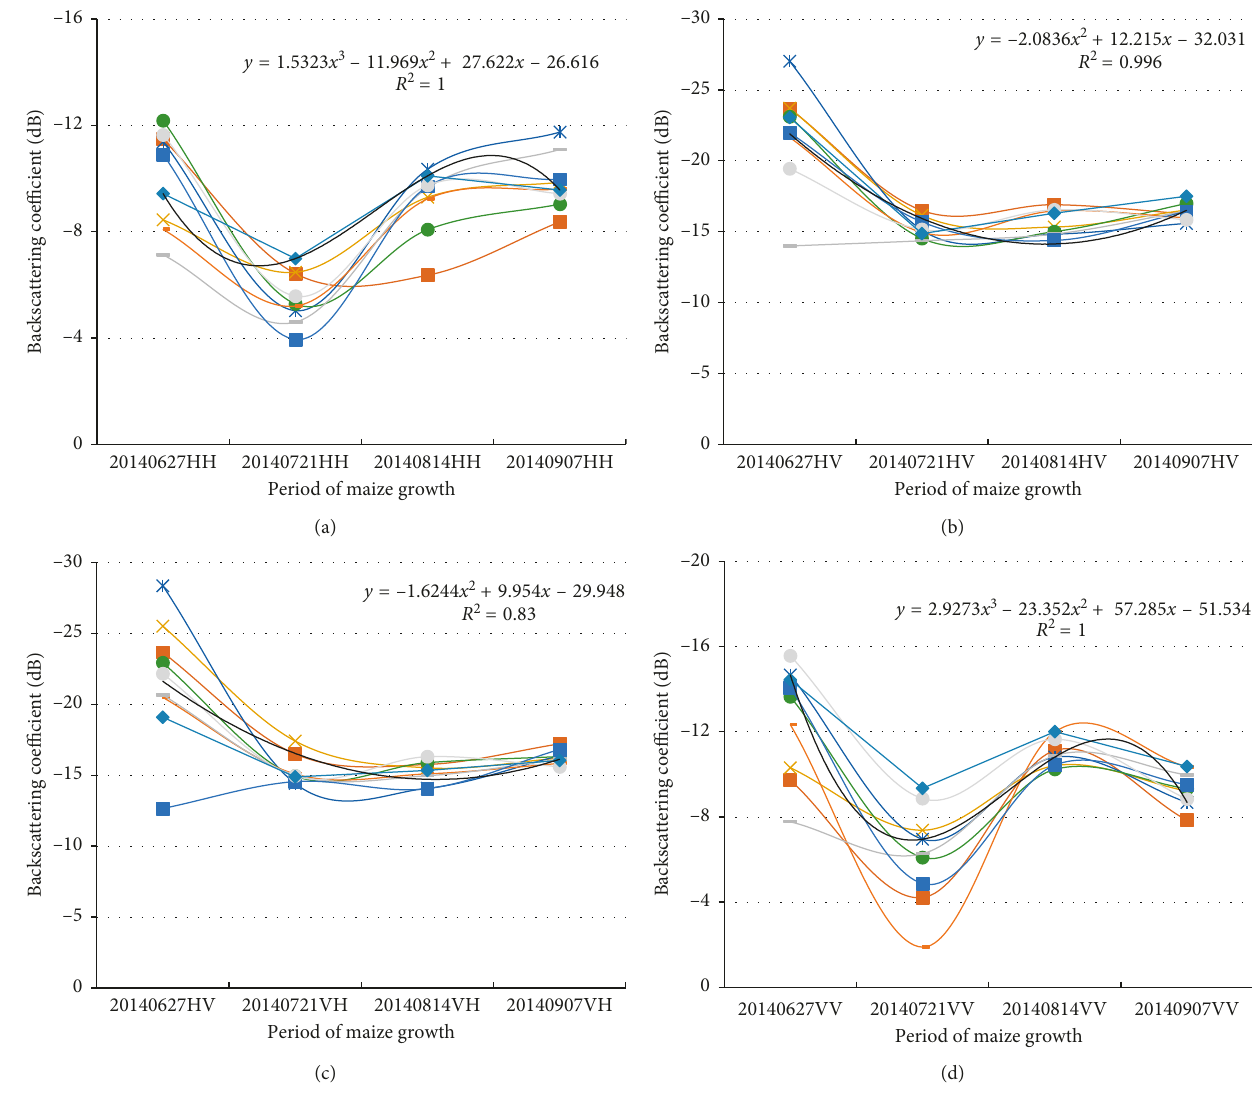
Figure 5: Backscattering coefficients used to evaluate cotton